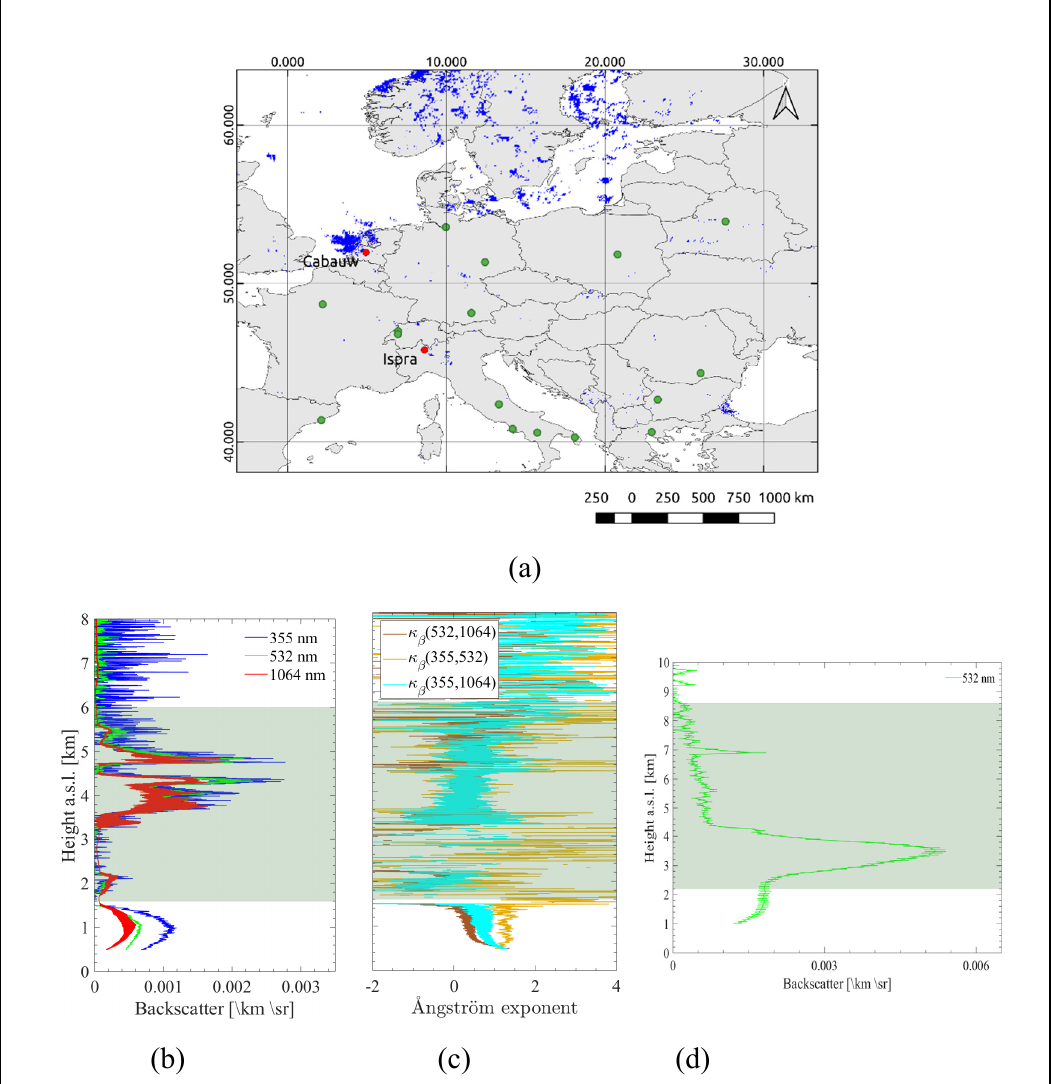
Figure 6. ( a ) Tailored RST ASH products of May 18 at 12:00 UTC and EARLINET measurement stations (in red) generated using the same algorithm arrangement as Figure 5 and revealing the presence of ash in green sites where no information was available. ( b ) Cabauw EARLINET aerosol backscatter coefficient and ( c ) Ångström exponent profiles acquired the same day between 11:33–12:19 UTC. ( d ) Ispra EARLINET aerosol backscatter coefficient acquired the same day between 11:30–12:30 UTC. The green area indicates the dust-affected portion of the profile.